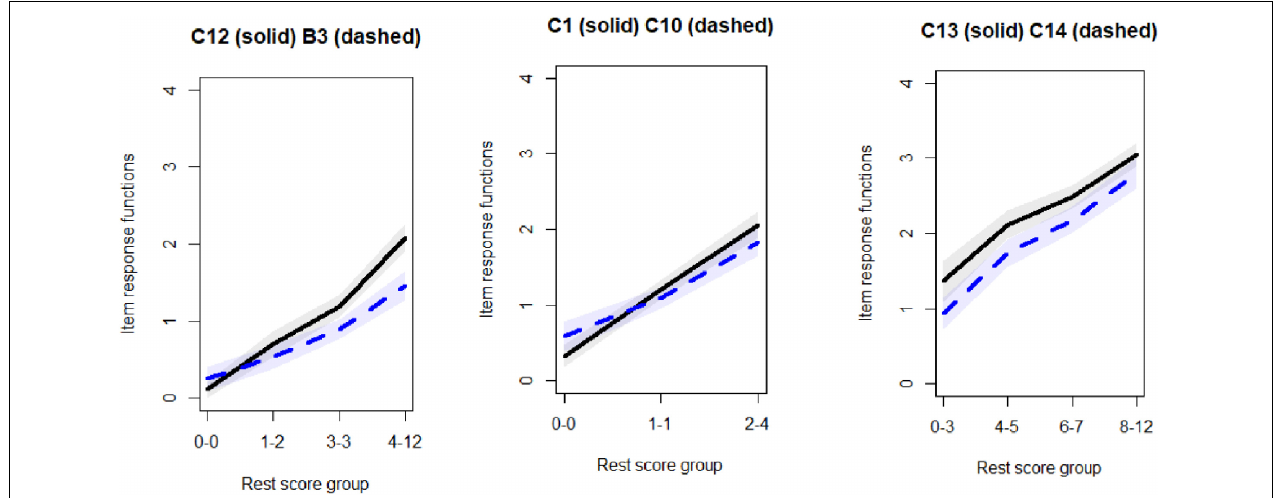
FIGURE 4 | Invariant item ordering evaluations of few items, violations of invariant item ordering (IIO) for the two figures in the left, while no violation for the utmost in the right.